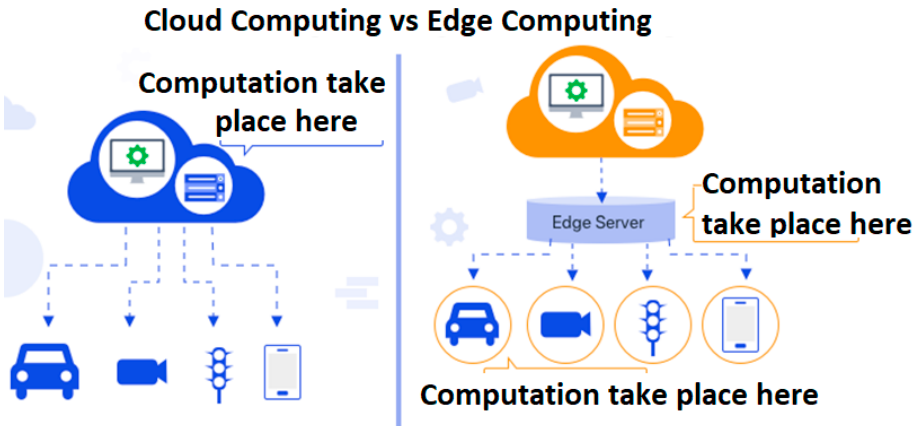
Figure 1. Difference between the cloud and edge computing [17].